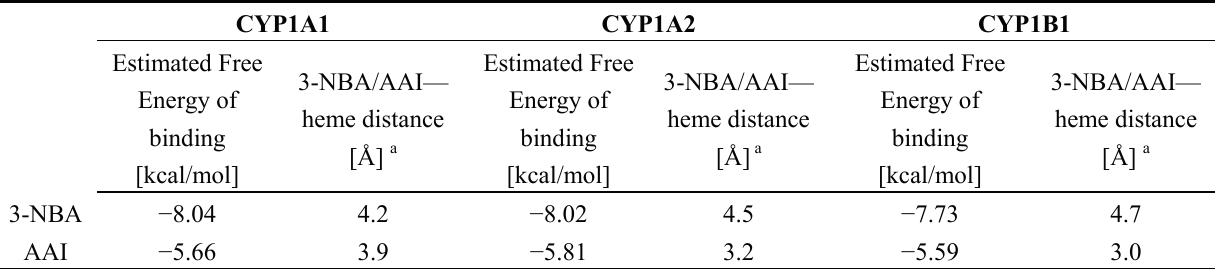
Table 5. The estimated binding free energies and distances between 3-NBA and AAI ligands and heme cofactor of CYPs for the best ranked complexes shown in Figures 6 and 7. Data for AAI are taken from our previous work